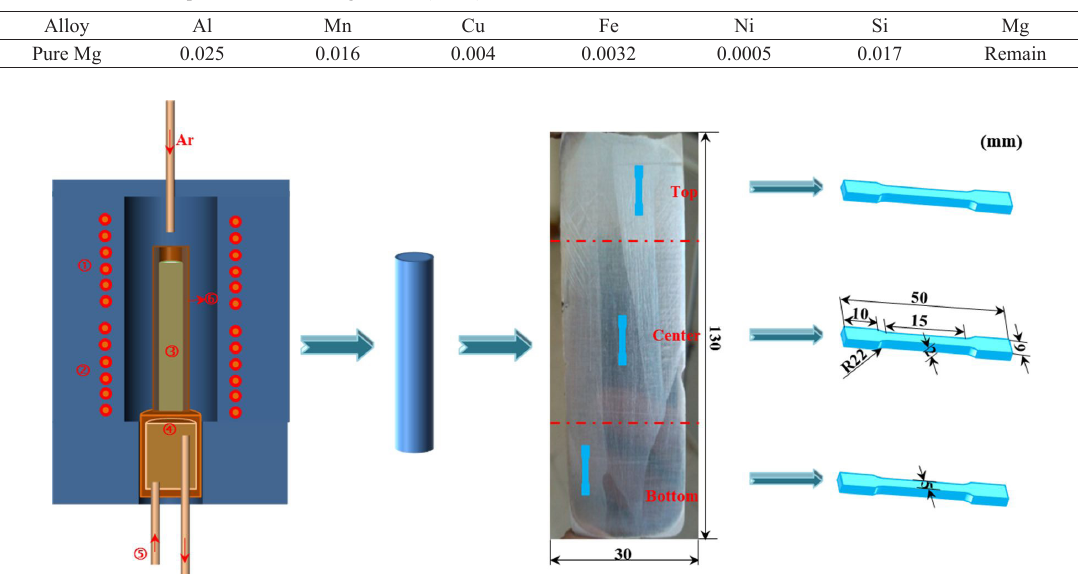
Figure 1. Schematic of the experimental set-up and the position and dimension of tensile specimens: ① - the top set of resistive wires, ② - the bottom set of resistive wires, ③ - magnesium melt, ④ - water-cooled copper base, ⑤ - cooling water, ⑥ - stainless steel crucible